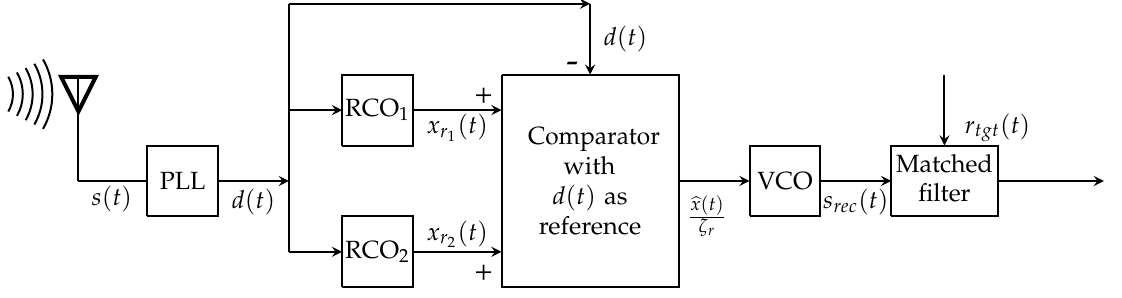
Figure 9. Architecture for the bistatic radar